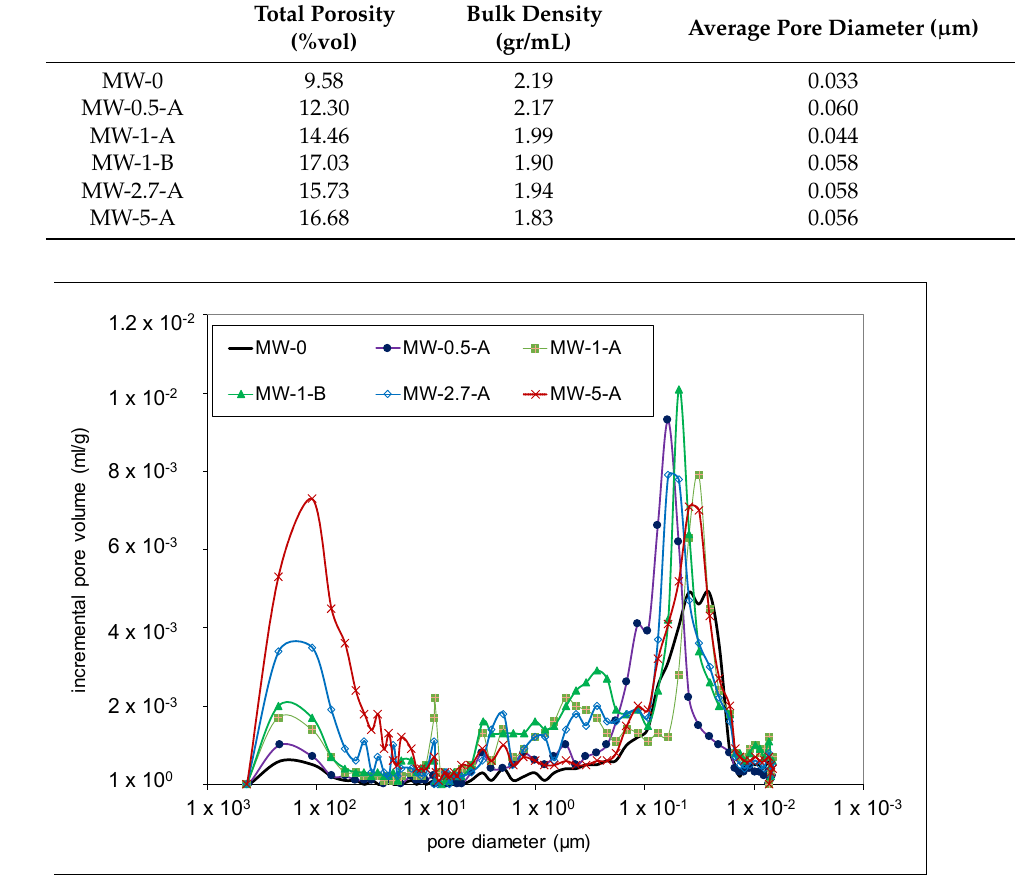
Figure 4. Differential pore size distributions of the specimens.